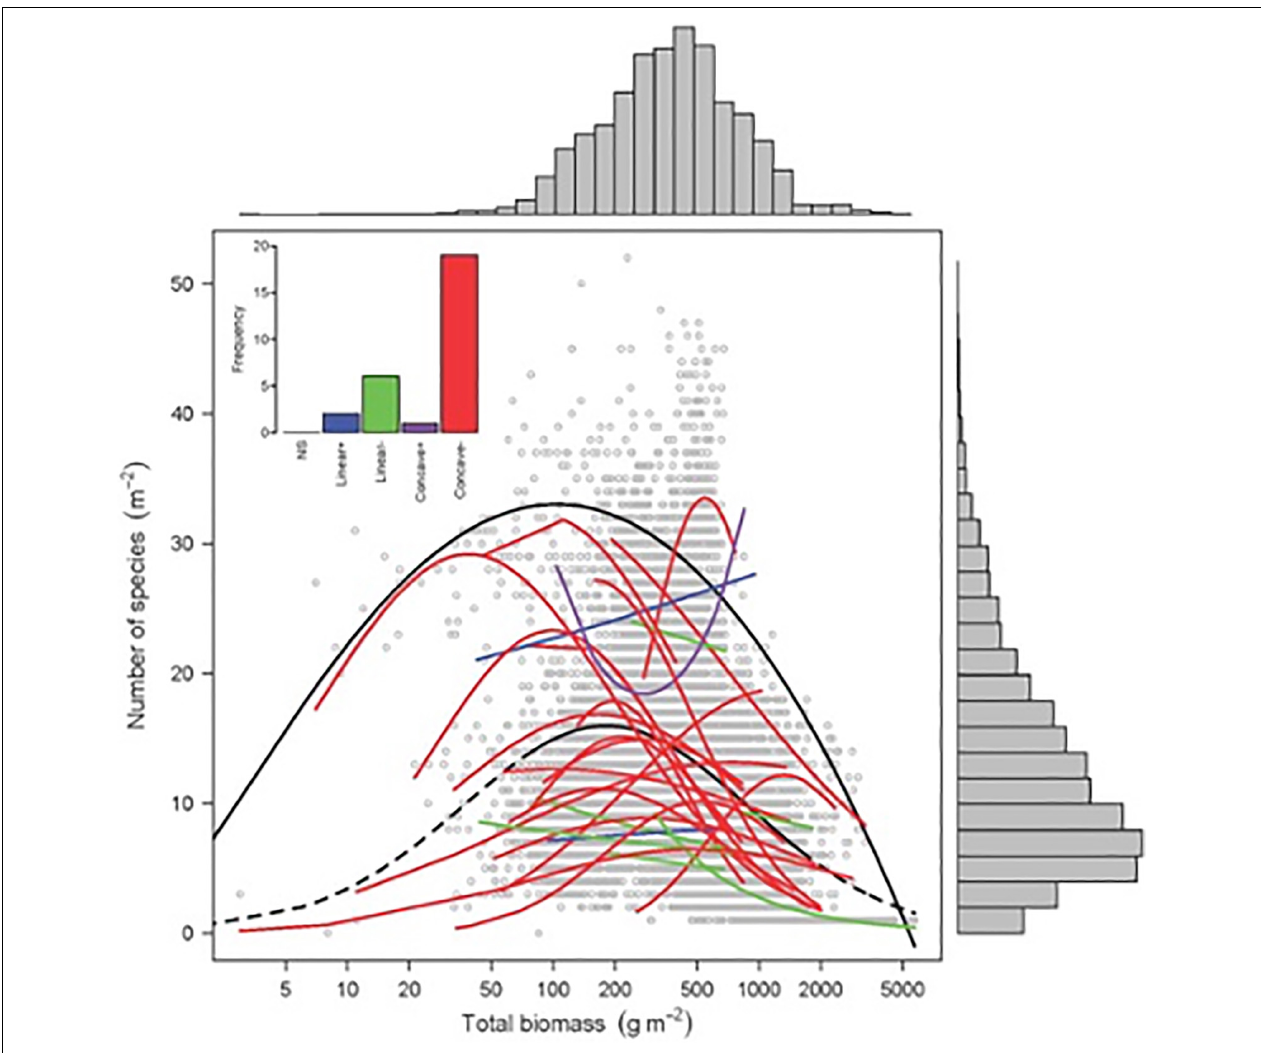
FIGURE 3 | Biomass–richness relationship for 28 grasslands across the world. Black solid line: significant quantile regression (95%) of overall relationship ( P < 0.001; n = 9631 quadrats). Colored lines: significant GLM regressions (Poisson or quasi-Poisson), with N ranging from 128 to 894 (Source: Fraser et al., 2015). Reprinted with permission from AAAS, permission no: